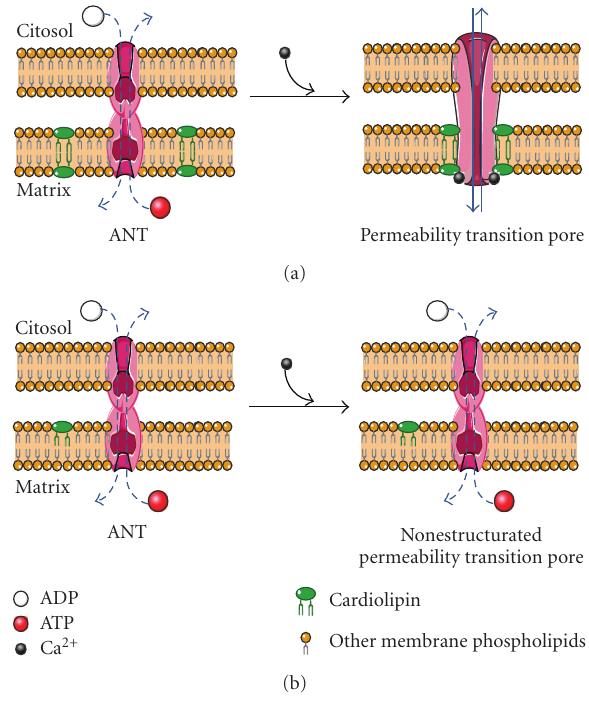
Figure 1: Conversion of the adenine nucleotide translocase (ANT) to permeability transition pore. (a) Under euthyroid conditions, ANT allows the selective exchange (dotted lines) of ADP and ATP between the citosol and the mitochondrion matrix. Ca 2+ triggers the assembling of ANT with cardiolipin and other proteins (not shown in the figure) to integrate the permeability transition pore. (b) In hypothyroidism, the low content of cardiolipin in the mitochon- drion membrane limits the pore formation, thus conserving the ANT function and matrix content unaltered. See the text for